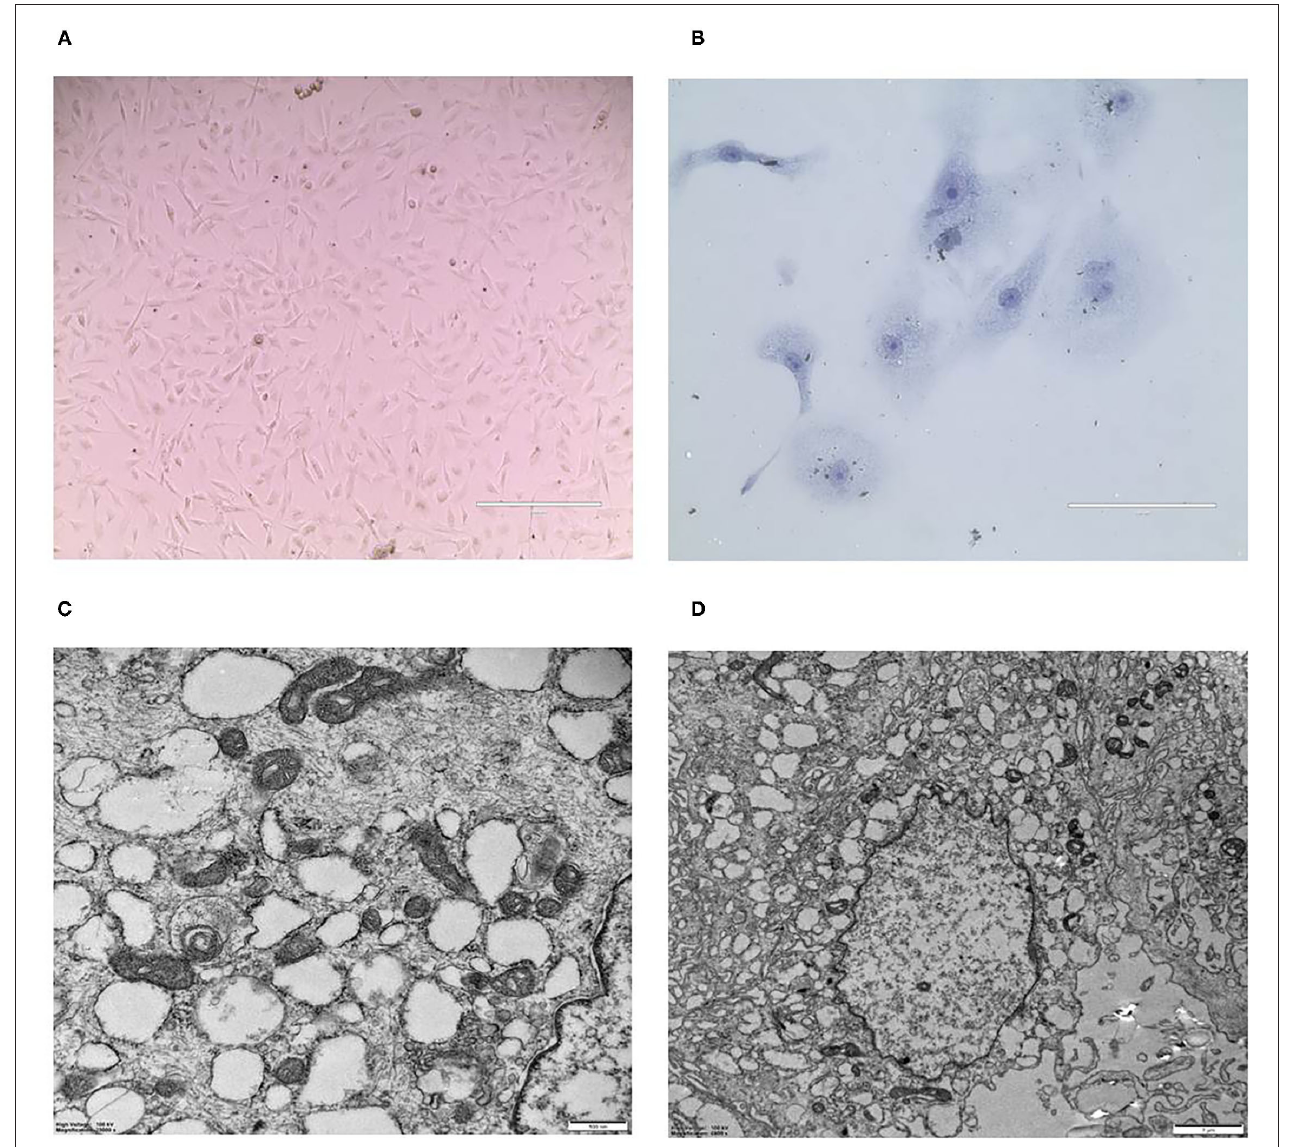
FIGURE 3 | Morphology of CMT-1026 cells. (A) Purified CMT-1026 cells, detected with inverted microscopy (10 × ). (B) CMT-1026 pellet; Diff-Quik staining (40 × ). Malignant cancer cells with epithelial morphology, marked anisokaryosis, and multinucleated giant cells. (C) Ultrastructural experiments revealed that CMT-1026 contained multiple organelles, mitochondria, secretory vacuoles, and endoplasmic reticulum. (D) Degenerated CMT-1026 cells, showing shrunken nuclei, and abundant proteinaceous secretion.